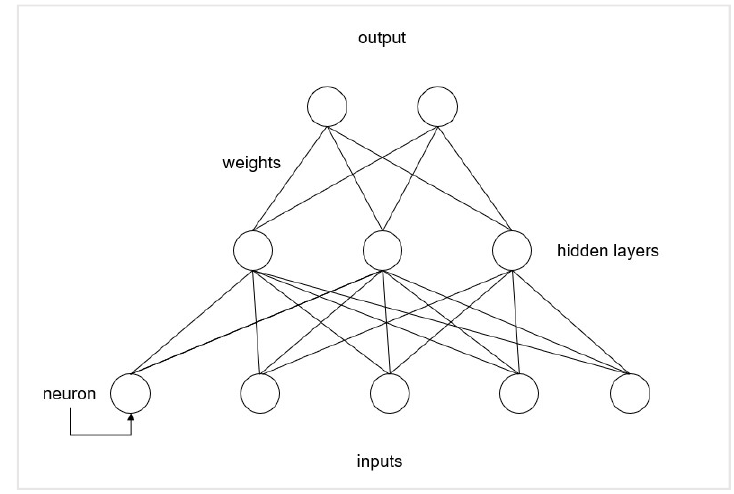
Figure 1. General architecture of a neural network. Neurons are interconnected and connections are represented by lines that integrate different layers of the model. Each connection is associated with a number, called a “weight” of the model. The model output ( h i ) from each neuron ( i ) in the hidden layer can be represented by Equation (1):